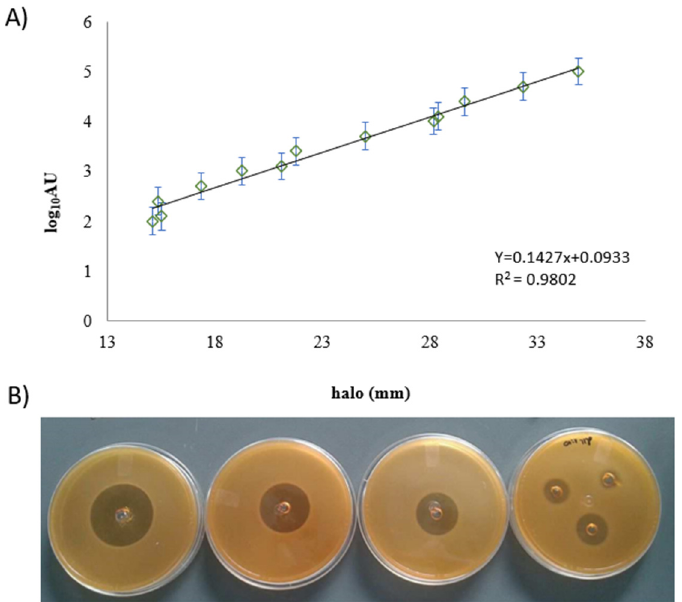
Figure 1. ( A ). Nisin standard curve by agar diffusion assay. ( B ) Agar diffusion assay image to represent the diameter of the inhibition halo.